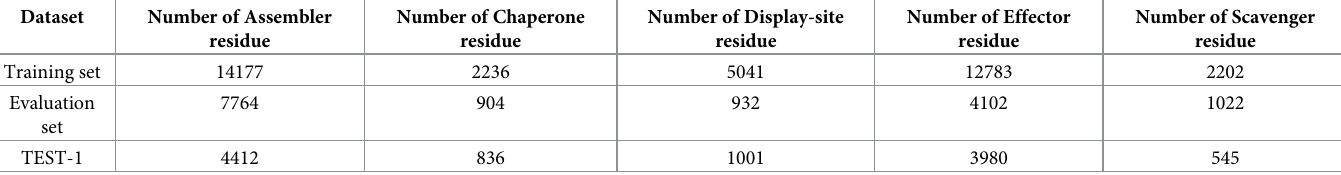
Table 1. The number of functional residues in the DMF benchmark